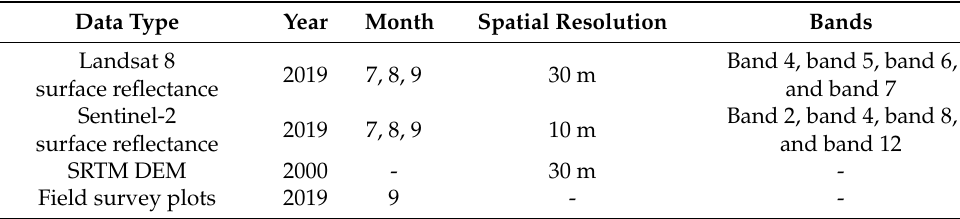
Table 1. Details of datasets used in the estimation of forest canopy closure.